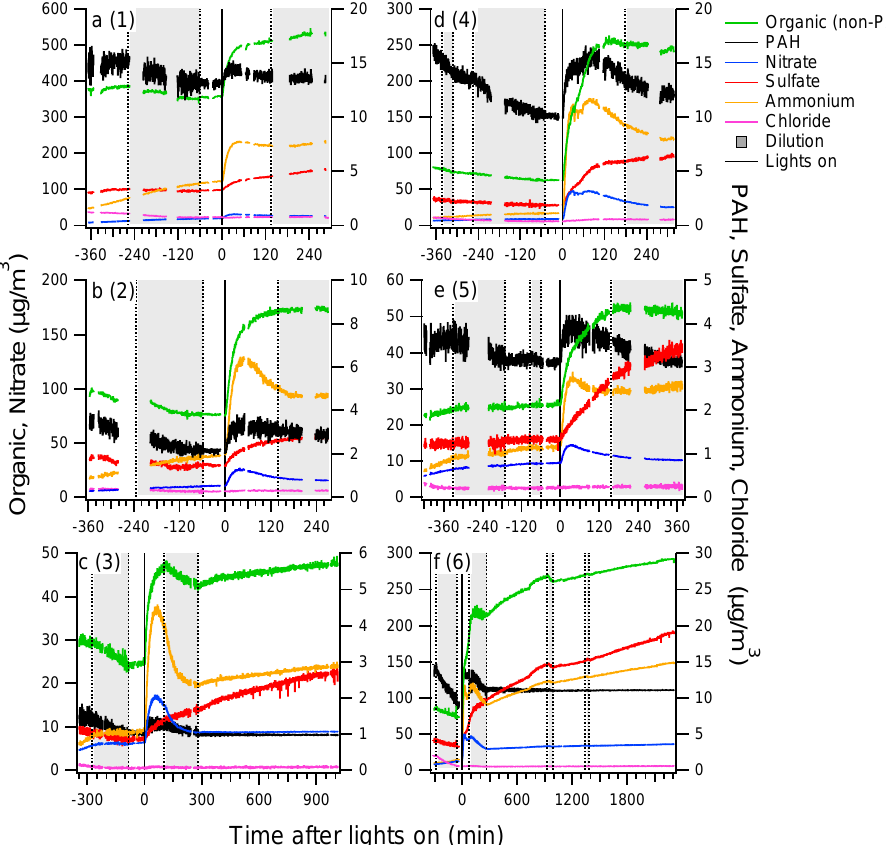
Figure 2. Evolution of components measured by AMS after injection into the chamber until the end of the experiment for (a–c) average-load experiments 1–3 and for (d–f) high-load experiments 4–6. Traces have been corrected for wall losses and dilution. The shaded areas indicate chamber refilling (dilution)